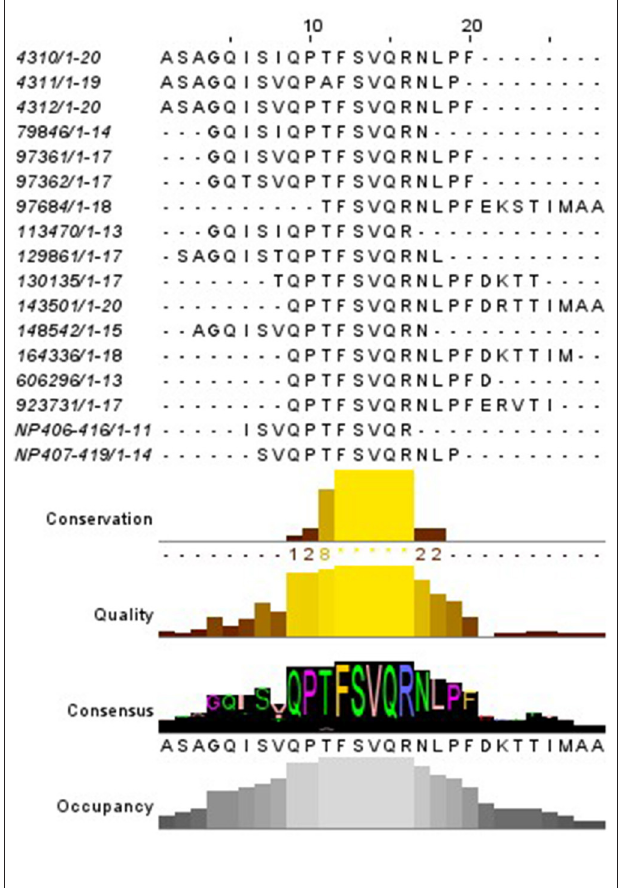
FIGURE 3 | Alignment of the MHC-II epitopes similar to NP 406 − 419 described. The red square indicates the region shared by most of the epitopes. The code on the left represent the IEDB reference.